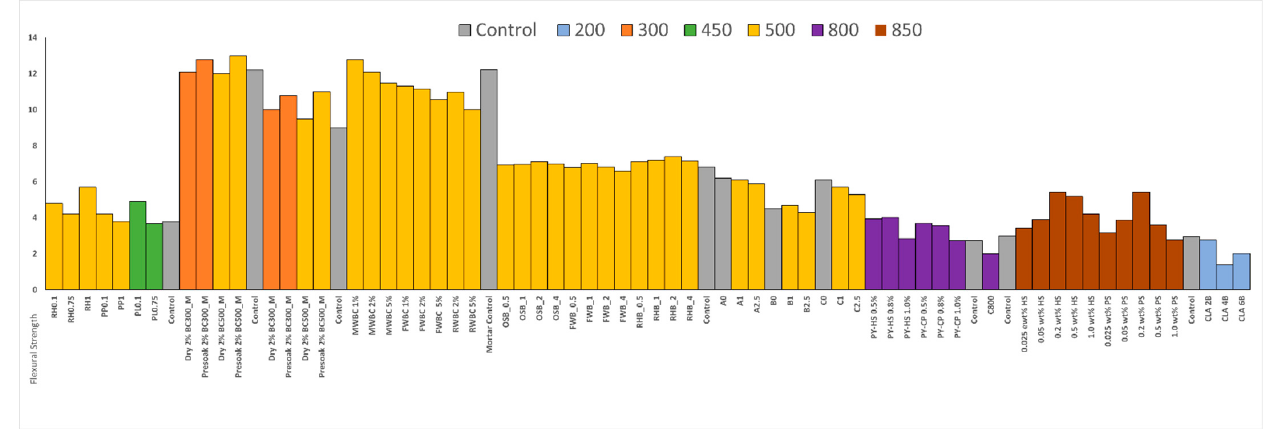
Figure 5. Flexural strength of biochar cement and concrete composites reported in previous studies.